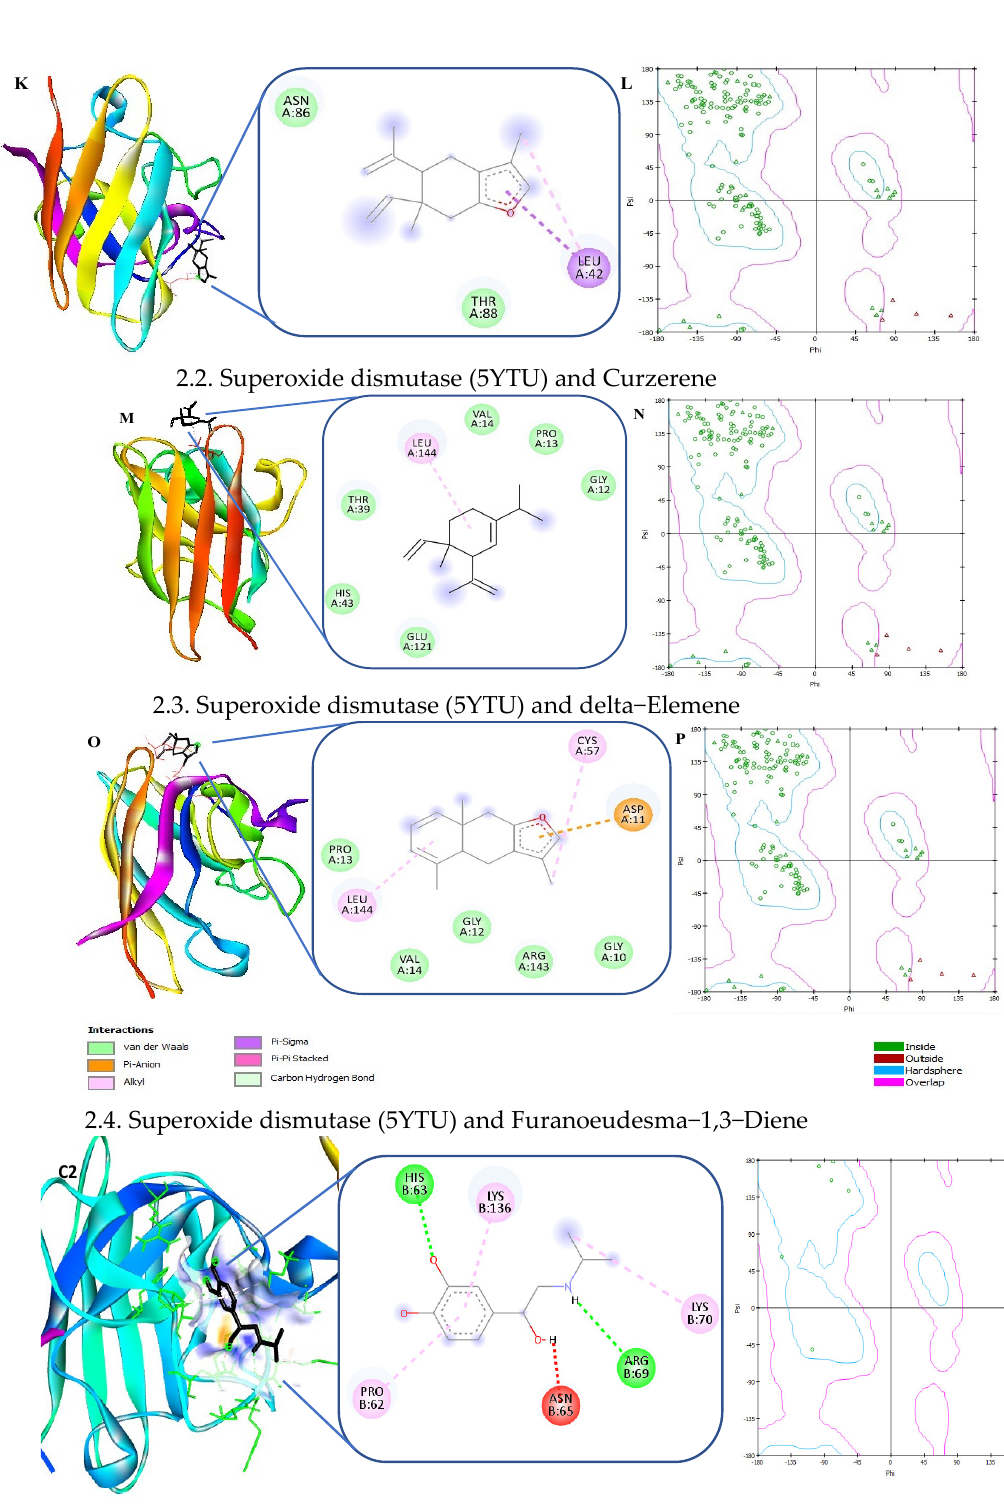
Figure 12. The docking investigations highlighting the interactions of antioxidants including Catalase (1DGH) and Superoxide dismutase (5YTU) to bioactive components of myrrh resin extract with ligands (1) 2,3−Furandione ( A , I ); (2) Curzerene ( C , K ); (3) delta−Elemene ( E , M ); and (4) Furanoeudesma−1,3−Diene ( G , O ), respectively. With every protein-−ligand interaction, Ramachandran plots for corresponding interactions have been presented ( B , D , F , H , J , L , N , P ). The positive controls are shown in ( C1 , C2 ).